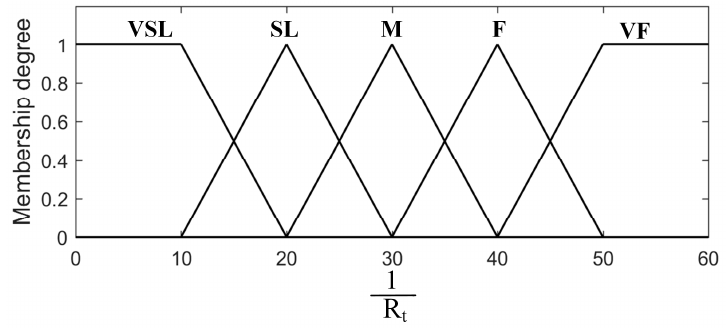
Figure 5. Membership function (output).